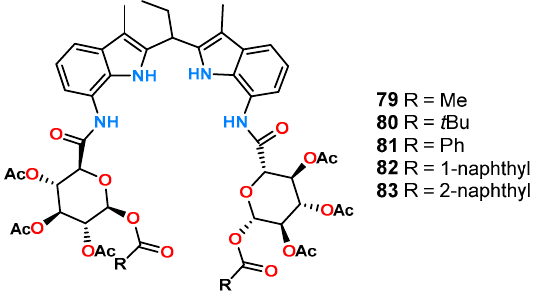
Figure 28. Sugar receptors 79 – 83 .